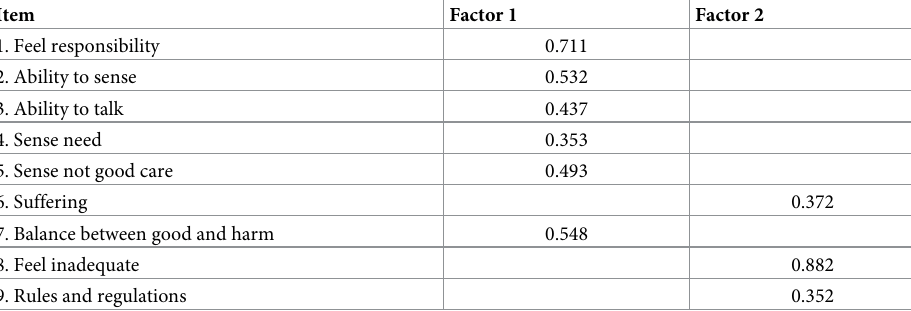
Table 4. Loading matrix related to the exploratory factor analysis solution.